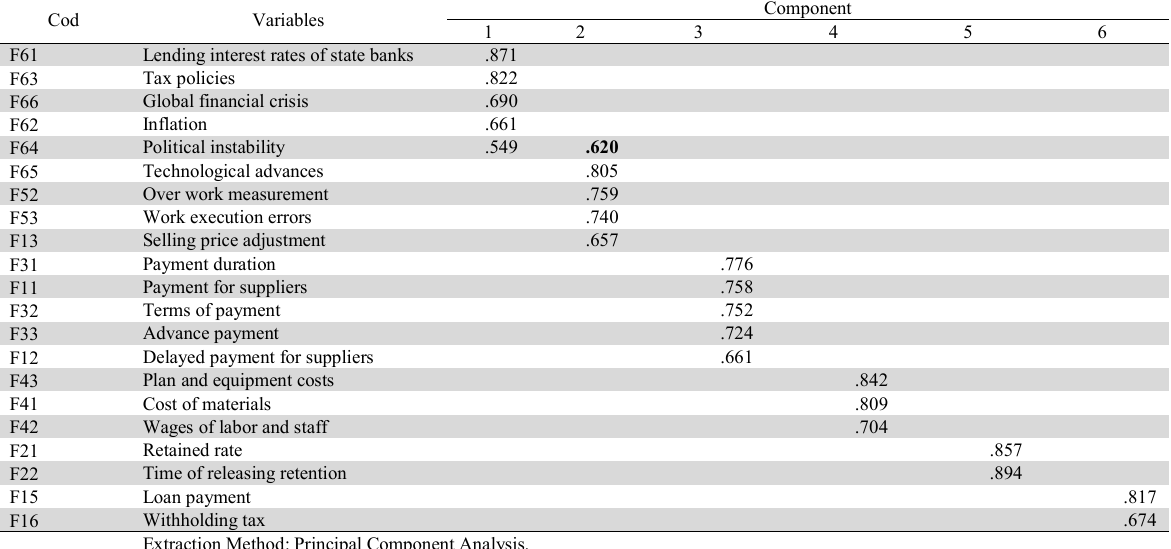
Rotated Component Matrix a Cod Variables